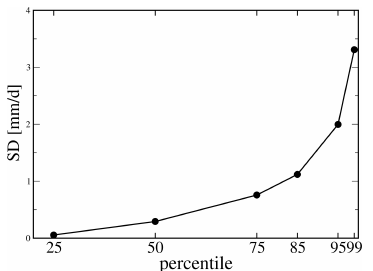
Figure 11. Inter-model standard deviation from the nine down- scaled models calculated for the 25th, 50th, 75th, 85th, 95th, and 99th percentiles of precipitation. The average over all the land grid cells of the models is shown. The percentiles have been derived from the 6-hourly time series of